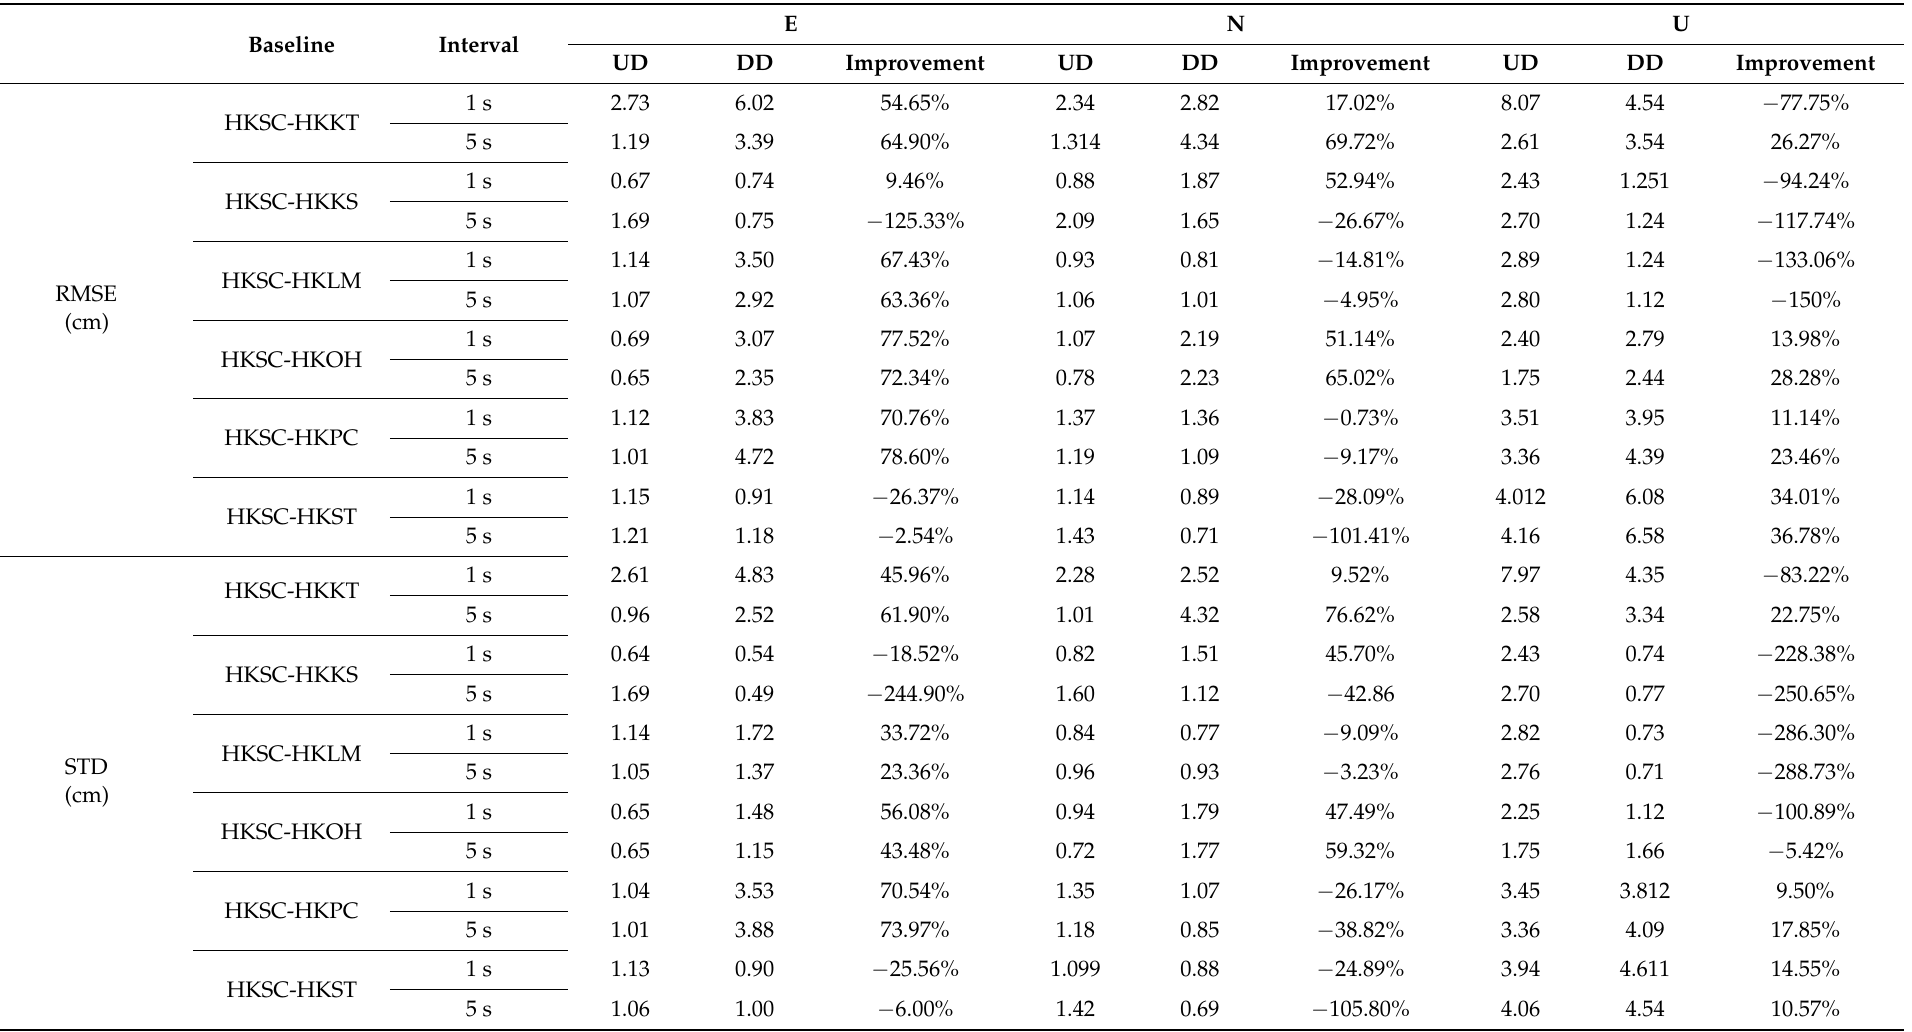
Table 4. RMS and STD improvement rate on